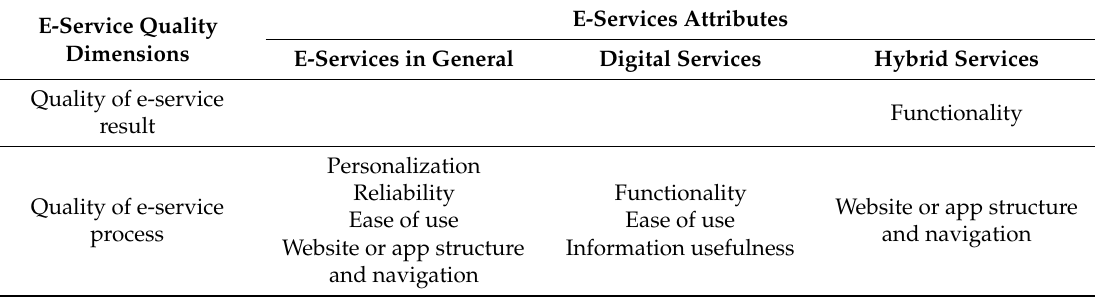
Table 9. Revised e-service quality dimensions and consumer